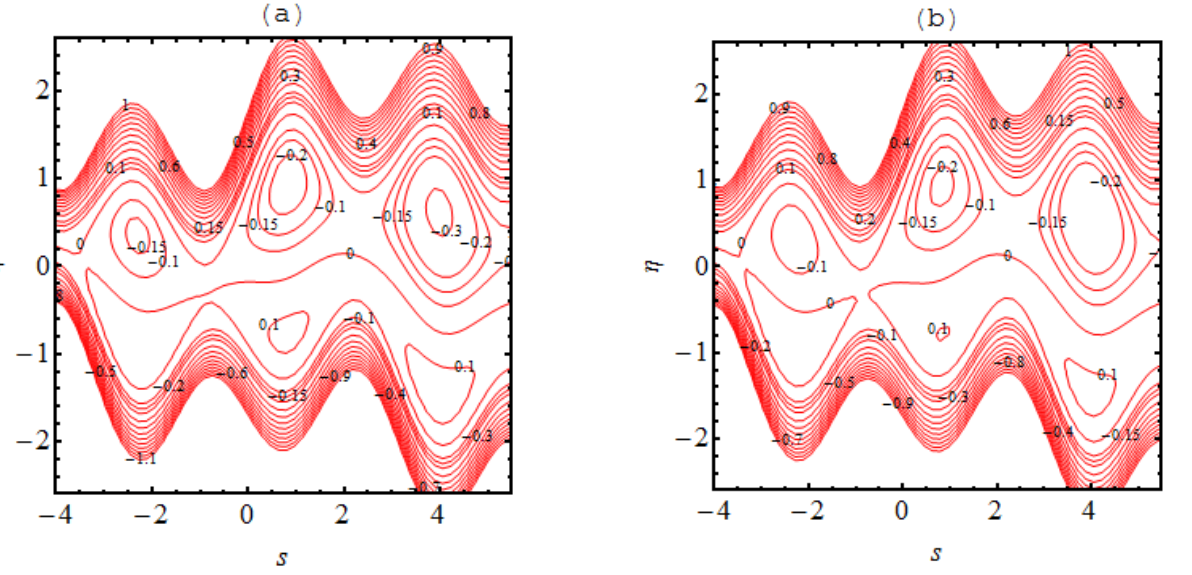
Figure 4. Stream lines for ( a ) α 1 = 0.0 and ( b ) α 1 = 0.1 the other parameters are Ha = 3.0, k = 3.0, m = 2.0, q = − 0.1, γ 1 = 1.0, β 1 =